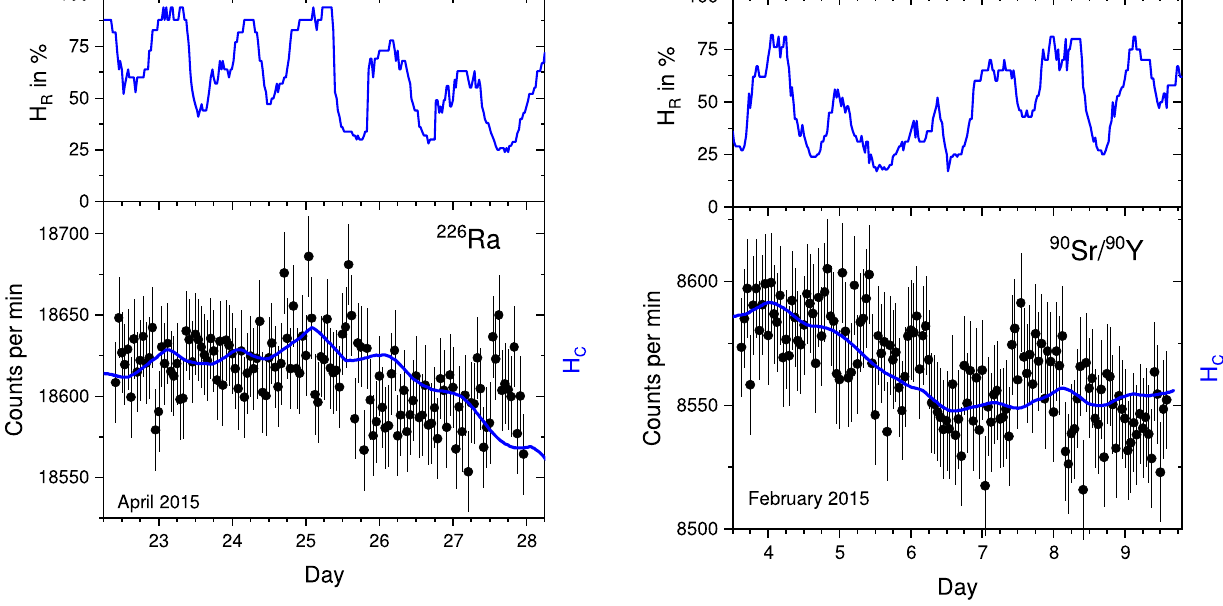
Fig. 4 Relative humidity in the Valencia region (top) in the period 3–9 Feb 2015 [68]. Qualitative comparison (bottom) of measured 90 Sr / 90 Y decay rates [27,29] with the accumulated-humidity model H C ( t ; ¯ H R = 56% ,(cid:3) t = − 7h ) in Eq. 1